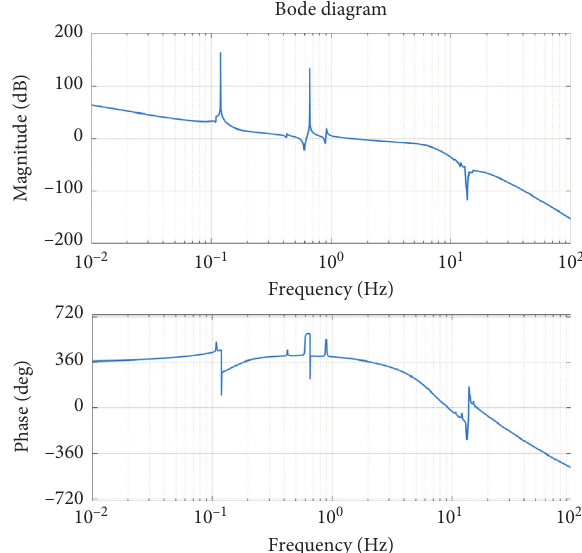
Figure 9: Open-loop frequency magnitude response of the system H